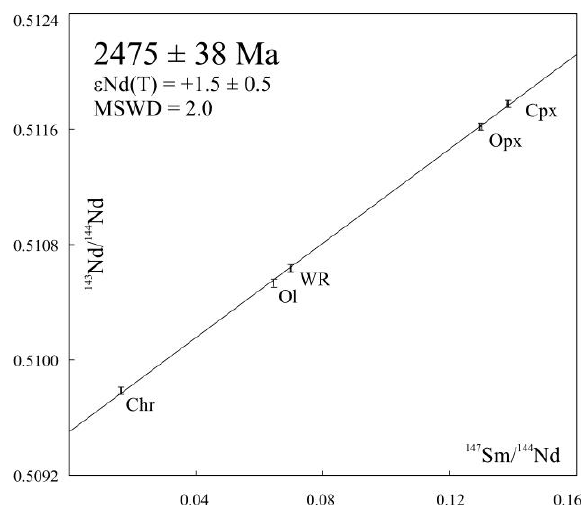
Figure 7. Mineral Sm–Nd isochron for harzburgites (P-1/1) with chromite mineralization, rhythmically layered series, third rhythm.